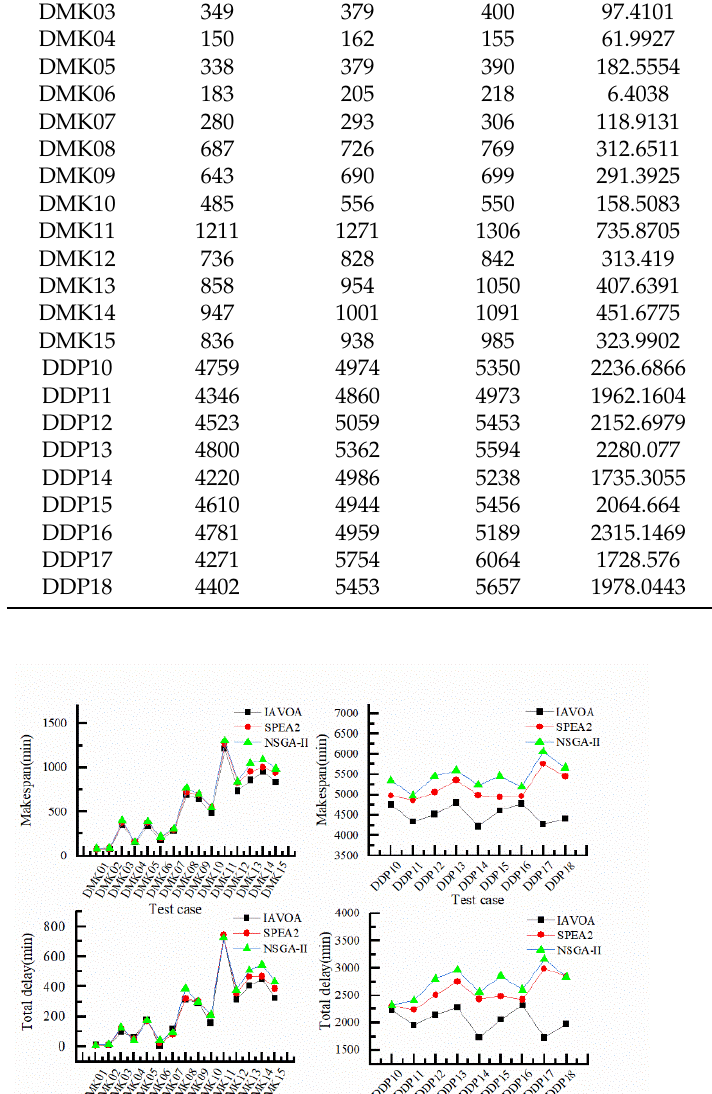
Figure 12. Convergence graph of DMK12.